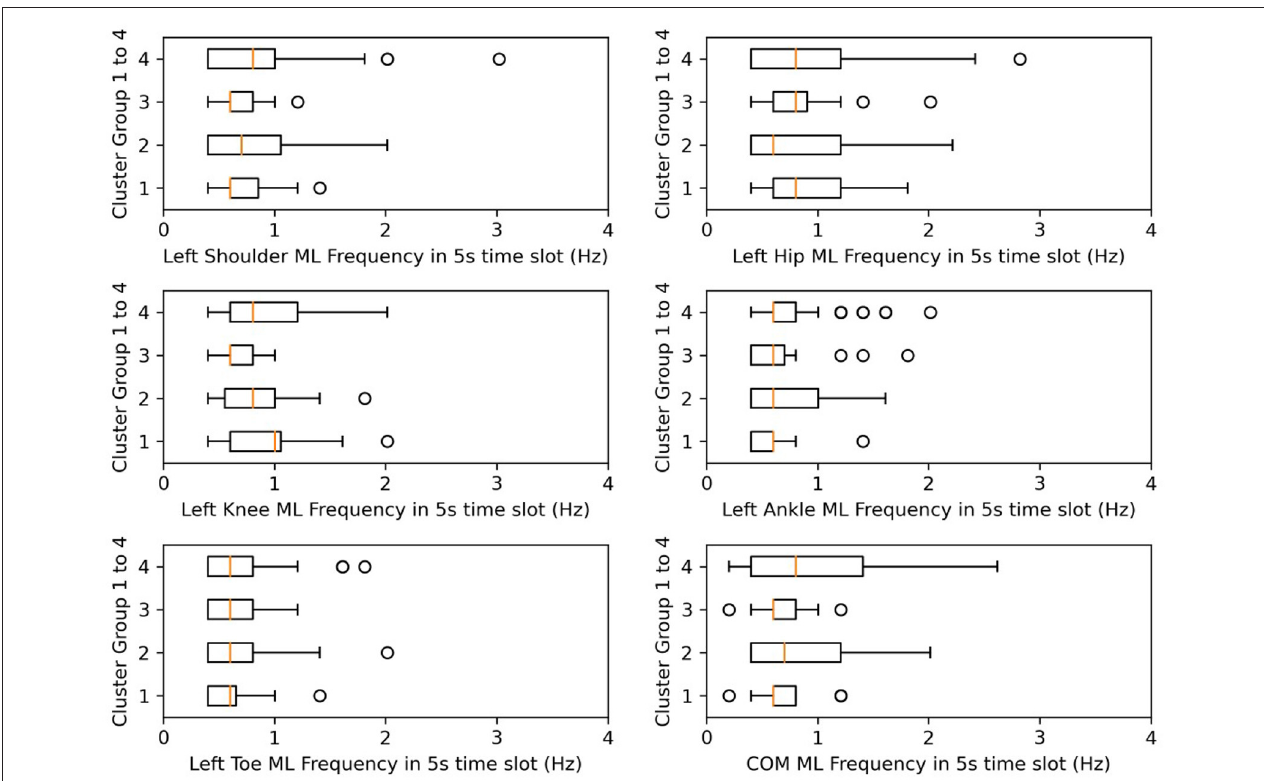
FIGURE 9 | Box plots for frequency in ML. X-axes represent the postural-sway frequency in the ML